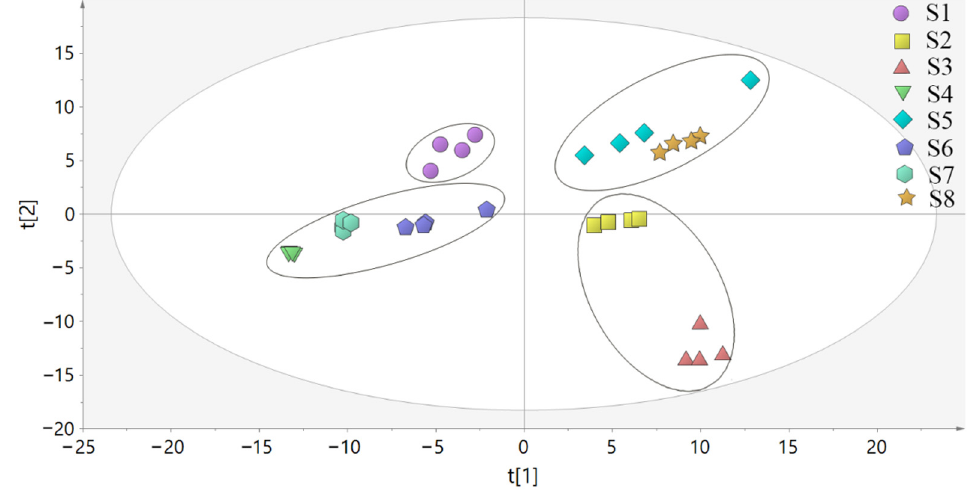
Figure 9. PCA score plot of LH samples from different habitats.